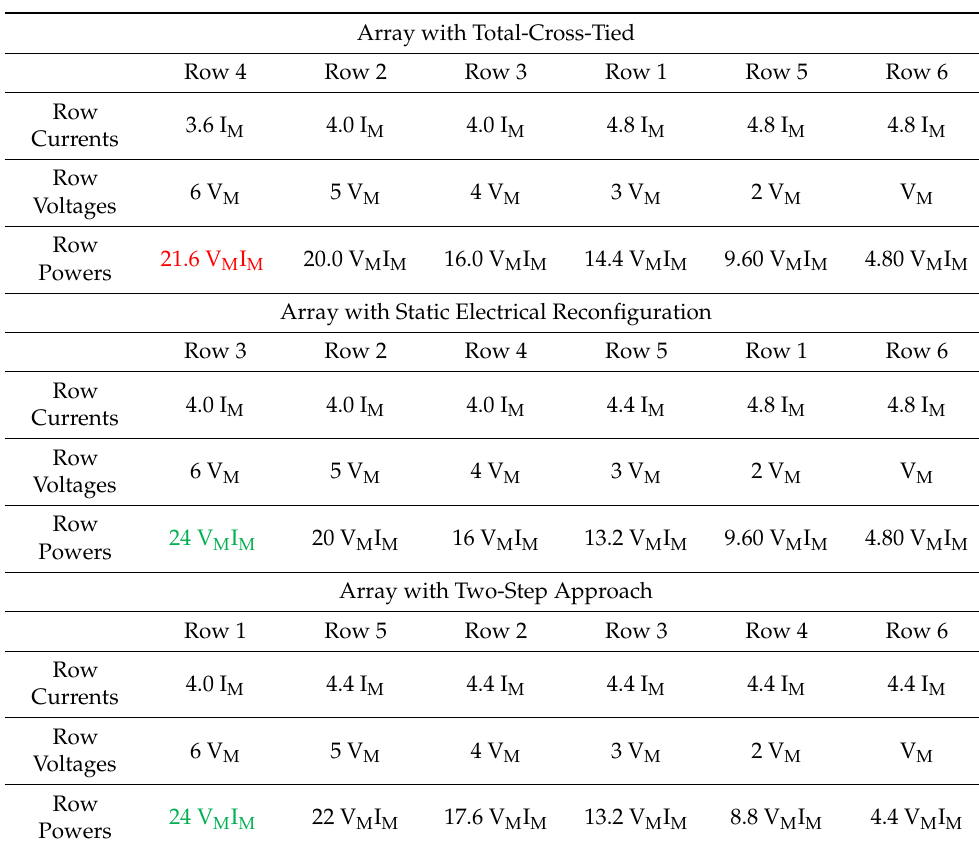
Table 3. Summarized mathematical estimation of the current, voltage and power values of the PV array under partial shading